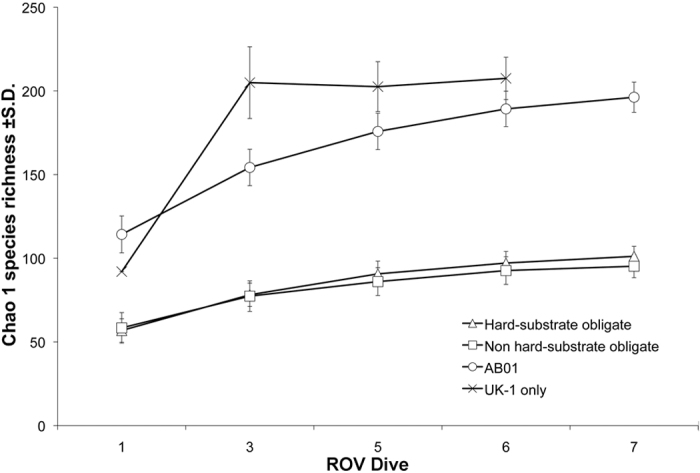
Chao-1 estimate of species richness (±s.d.) of epibenthic megafauna with increasing number of ROV dives during AB01 in the eastern CCZ.Circles = all megafauna surveyed during AB01 (five ROV dive sites); crosses = megafauna from only the UK-1 contract area (four ROV dive sites); triangles = megafauna observed only on hard substrata (nodules); squares = megafauna occurring on sediments or both sediments and nodules.